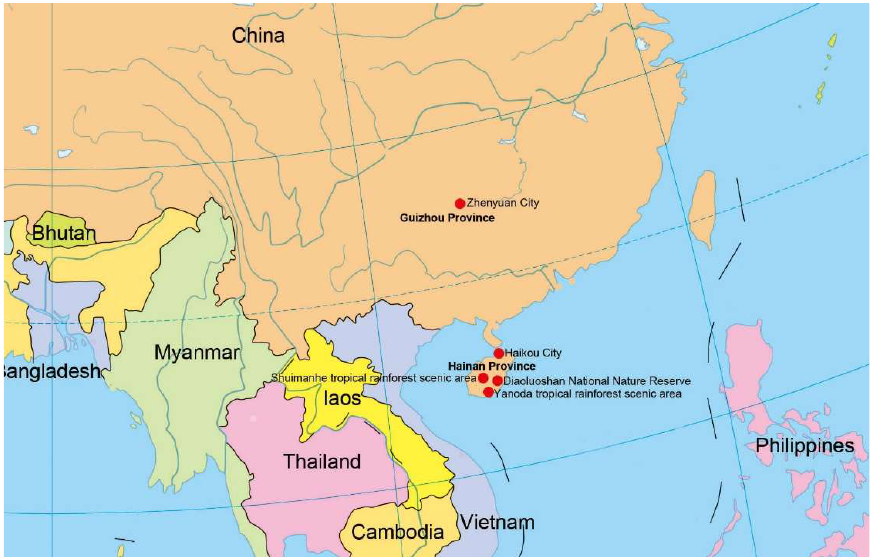
Figure 1. Collecting sites in this study (red dots). Single spore isolations were performed on water agar (WA) and germinated conidia were aseptically transferred to fresh potato dextrose agar (PDA) following the method of Senanayake et al. [30]. Cultures were grown on PDA and incubated in an incubator at 25 ◦ C for 5 weeks and morphological characters, including color, shape, and size were